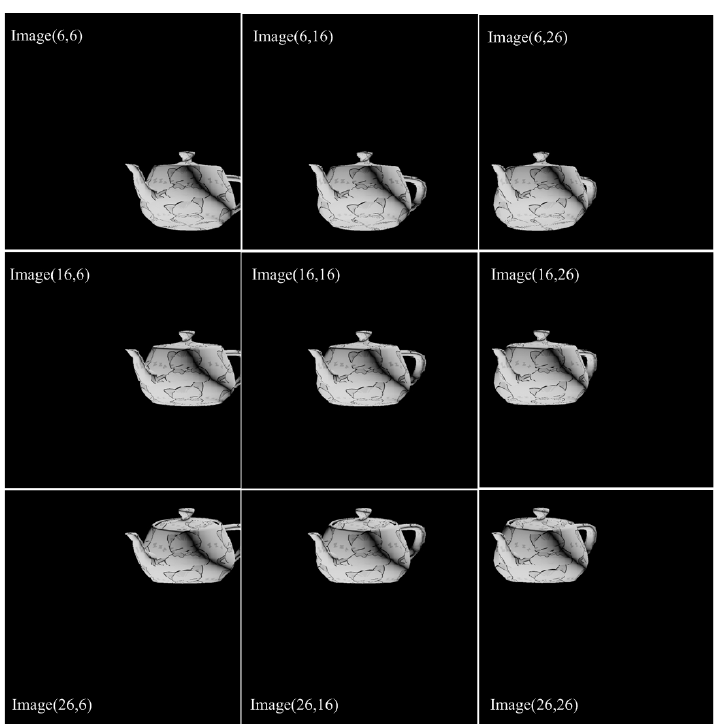
Figure 9. Synthetic perspective image of the holographic element-based EPISM